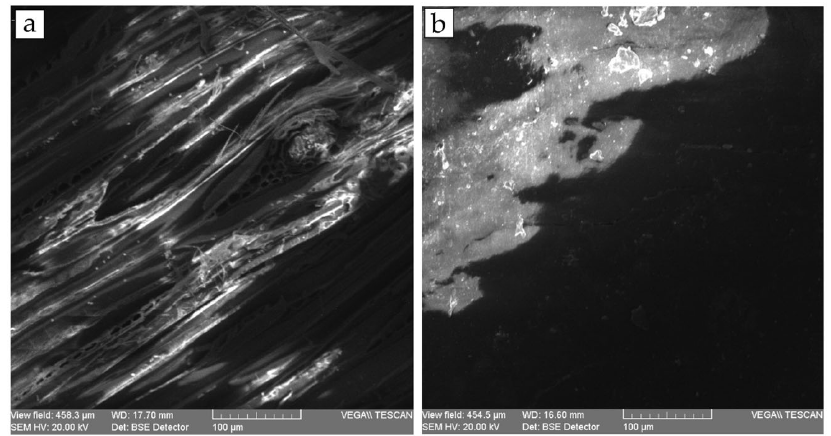
Figure 5. SEM micrograph of the wood sample from the top cover of the violin’s resonance box ( a ) and varnish ( b ).